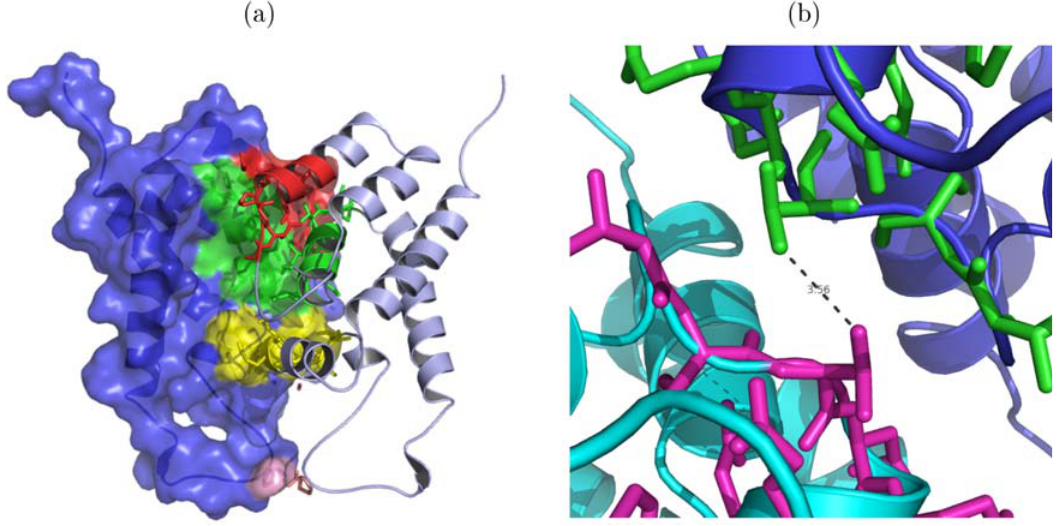
Figure 4. Crystal structure of a p24 dimer. Entry 1AFV from the protein data bank is shown (PDB, www.rcsb.org/pdb) [44,45]. (A) One monomer is shown in combined cartoon and surface representation to show the extent of the surface exposed part of the epitopes. For clarity, the other monomer is shown only in cartoon representation. The epitopes located in the dimer interface are highlighted in red (IW9), yellow (TW10) and green (DV9), and are also shown in stick representation. (B) A close-up of the dimer interface. The two monomers are shown in dark blue and cyan, and the TW10 epitopes are shown in green and magenta stick representations. The hydrophobic contact between T110 from one monomer to T110 in the other monomer is indicated by a dashed line.